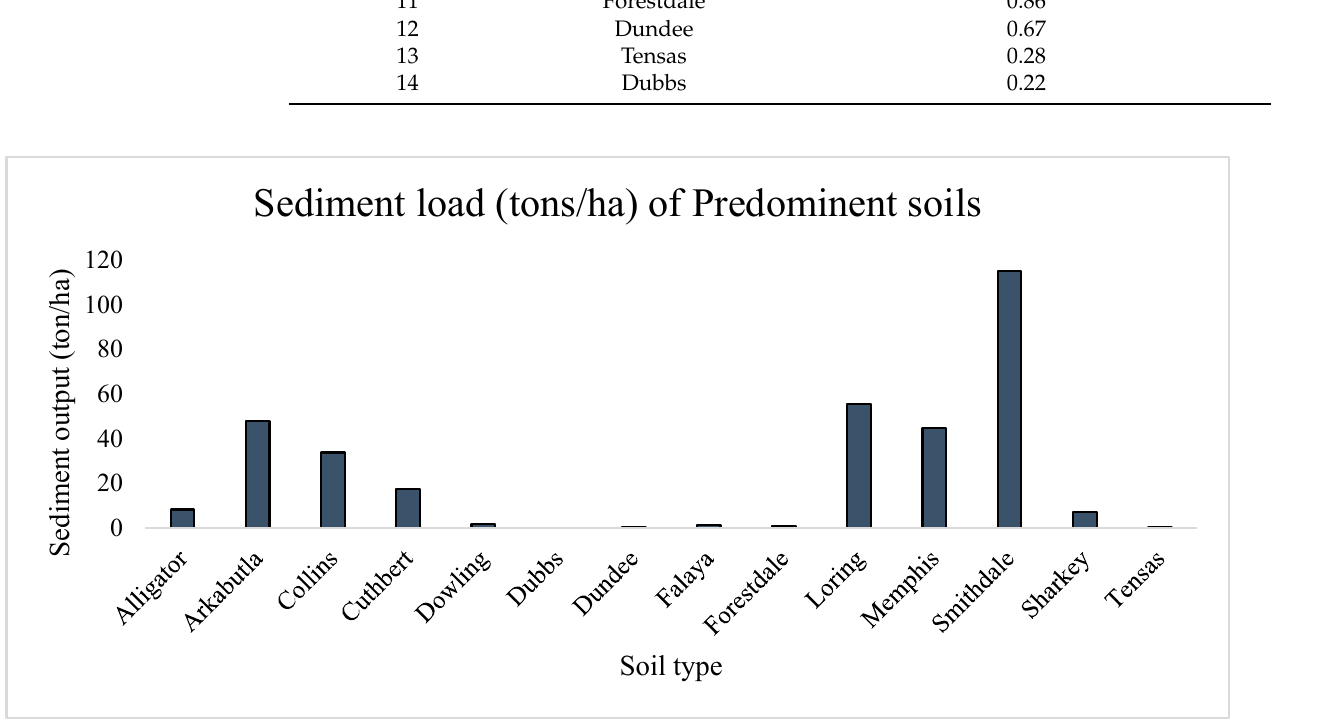
Figure 3. Sediment load comparison among soil types.